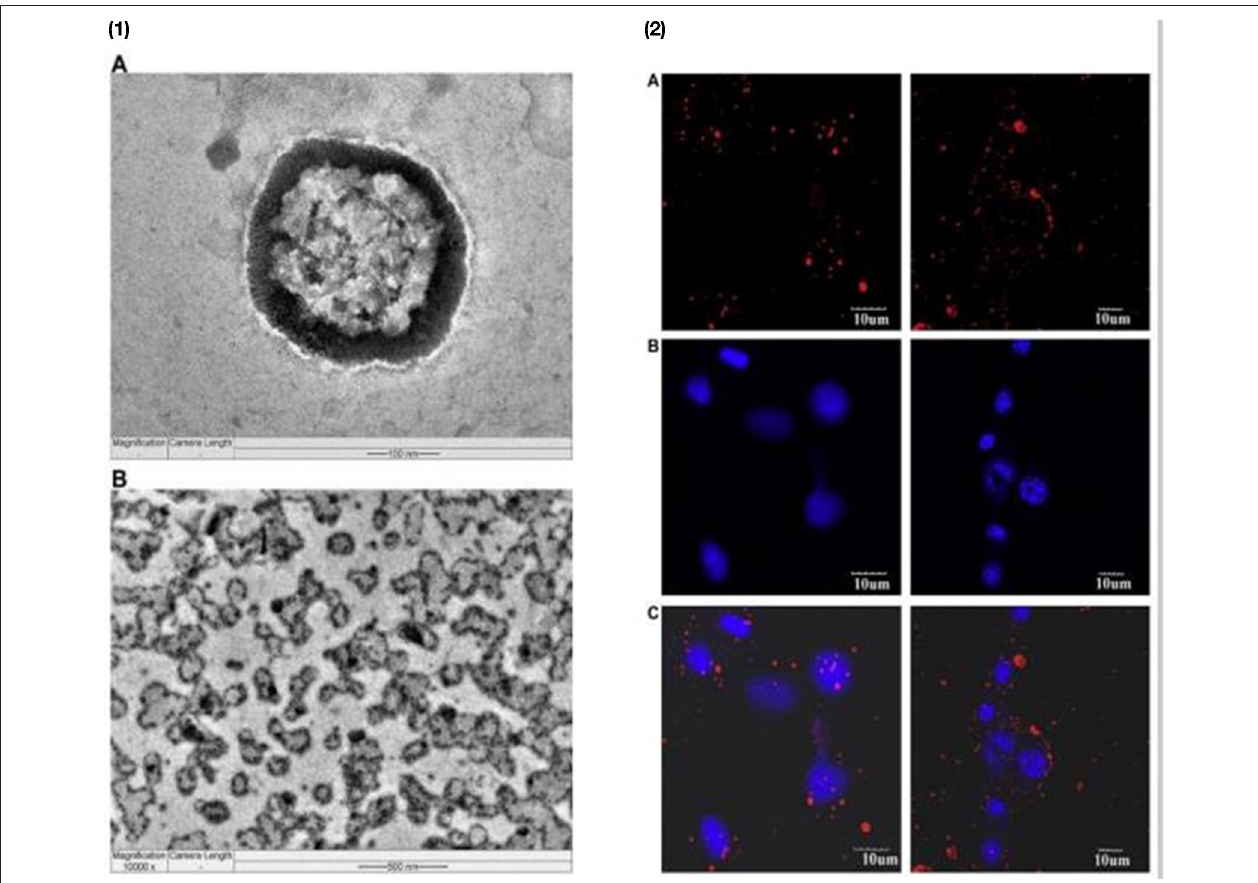
FIGURE 6 | TPGS liposomes were used to transport theranostic drugs in vitro . (1) (A) A single quantum dots-loaded TPGS coated liposome in a 100nm scale, and (B) multiple quantum dots-loaded TPGS coated liposomes after storage in a 500nm scale. (2) (A,B) Confocal laser scanning microscopy images of MCF-7 cells treated with non-targeted TPGS-based multi-functional liposomes (left column) and targeted TPGS-based multi-functional liposomes (right column) for 2h (right column). Quantum dots showing red fluorescence from cytoplasmic liposomes, (B) channels displaying blue fluorescence from dye-stained nuclei, and (C) quantum dots displaying blue fluorescence from dye-stained nuclei, and (C) Quantum dots and blue dye merged